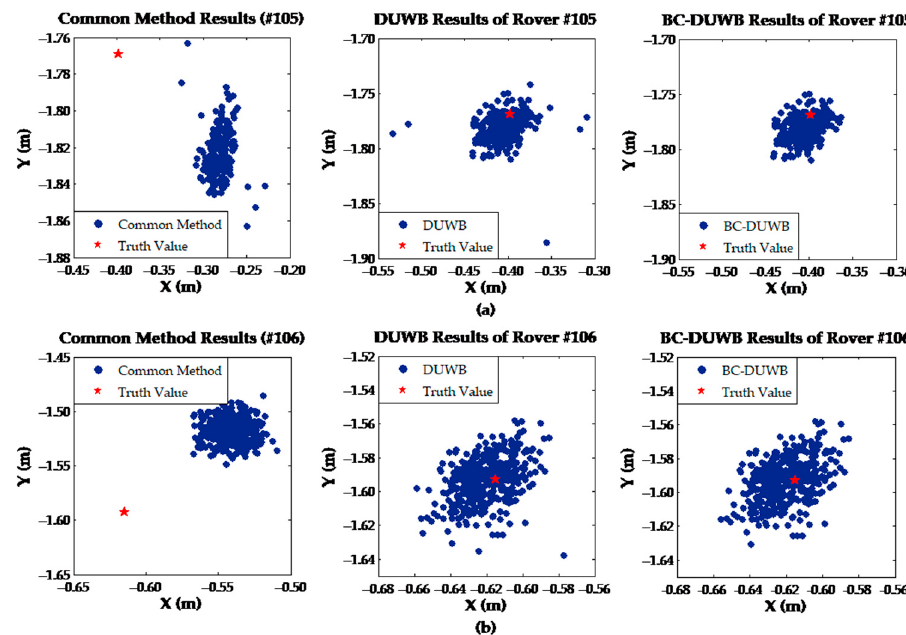
Figure 11. ( a ) The positioning results of rover #105 with different methods (Test 2); ( b ) The positioning results of rover #106 with different methods (Test 2).